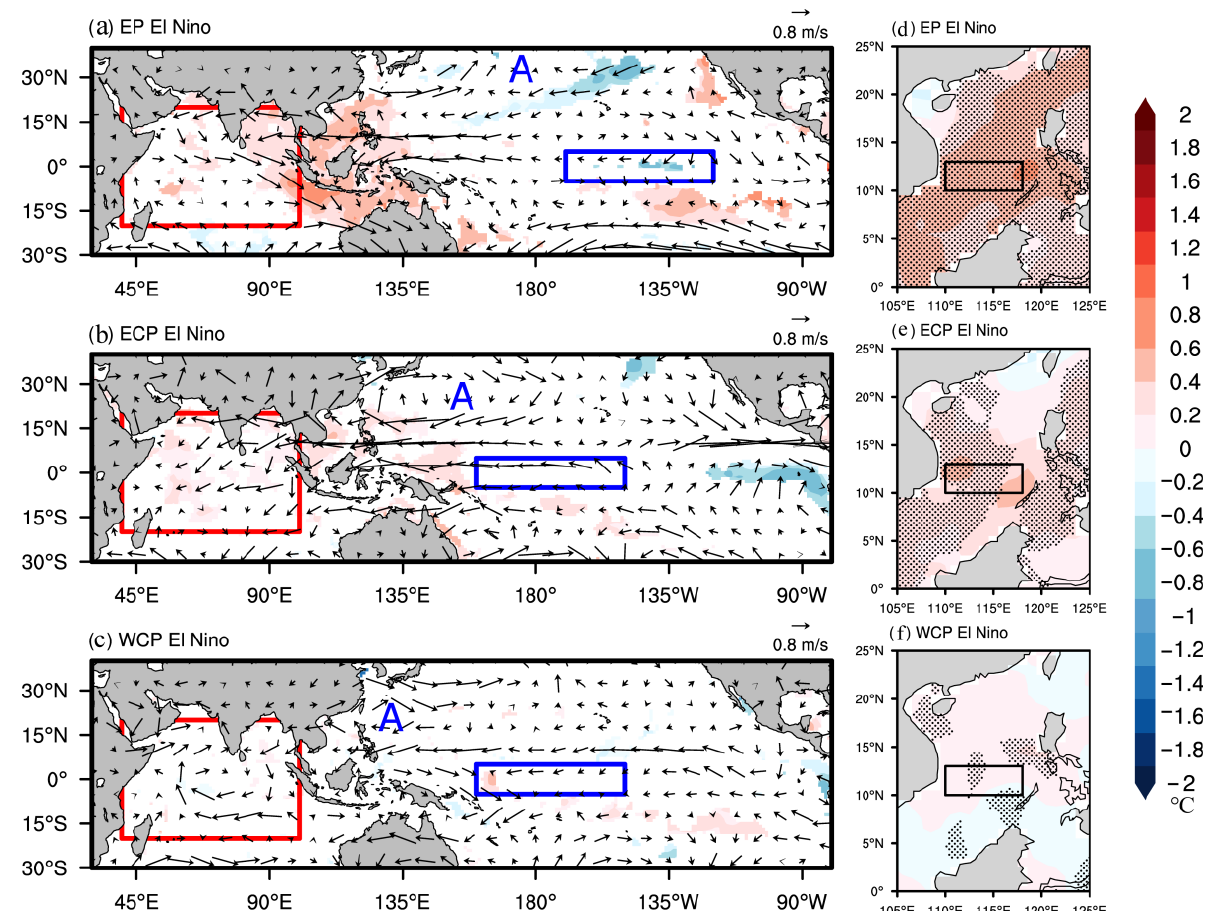
Figure 10. Composite SST anomalies (shaded, ◦ C) over tropical India–Pacific ( a – c ) and SCS regions ( d – f ) during boreal summer (JJA) for ( a , d ) EP El Niño, ( b , e ) ECP El Niño and ( c , f ) WCP El Niño. Only values reaching 85% significance level are shown in ( a – c ), the stippled area in ( d – f ) represents the values exceeding the 85% significance level. Vectors in ( a – c ) show anomalous wind (m · s − 1 ) at 850 hPa. The blue rectangle denotes the Niño3.4 region in ( a ) and the Niño4 region in ( b , c ), with “+” symbols standing for the location of the maximum zonal gradient of the equatorial (5 ◦ S–5 ◦ N) mean SSTA. Symbols A in ( a – c ) represent anomalous anticyclone and cyclone. Red rectangles in ( a – c ) represent the tropical Indian Ocean. Black rectangles in ( d – f ) represent the CT region.